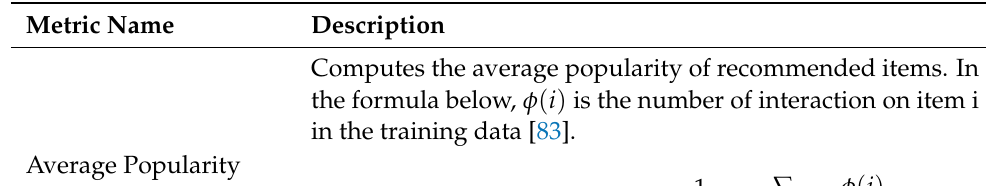
Table 6. Metrics for bias